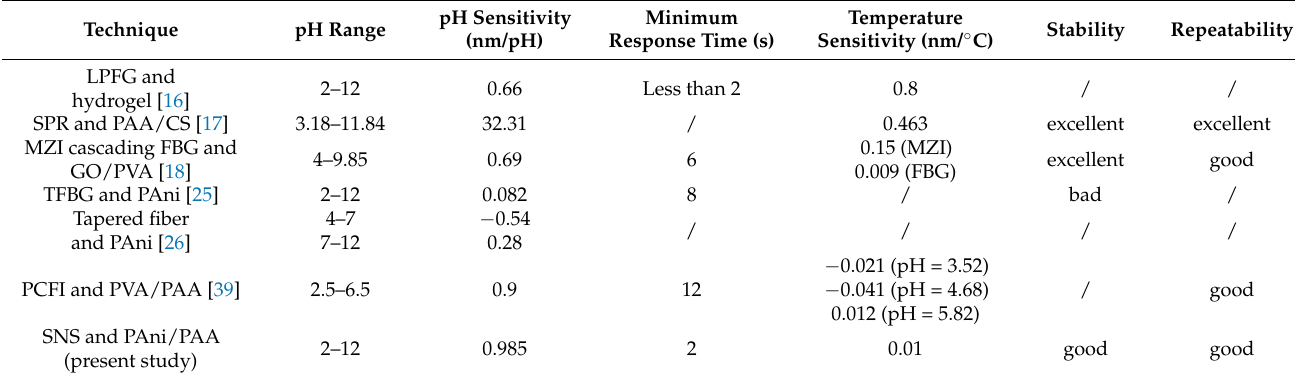
Table 1. Comparison of different optical fiber pH